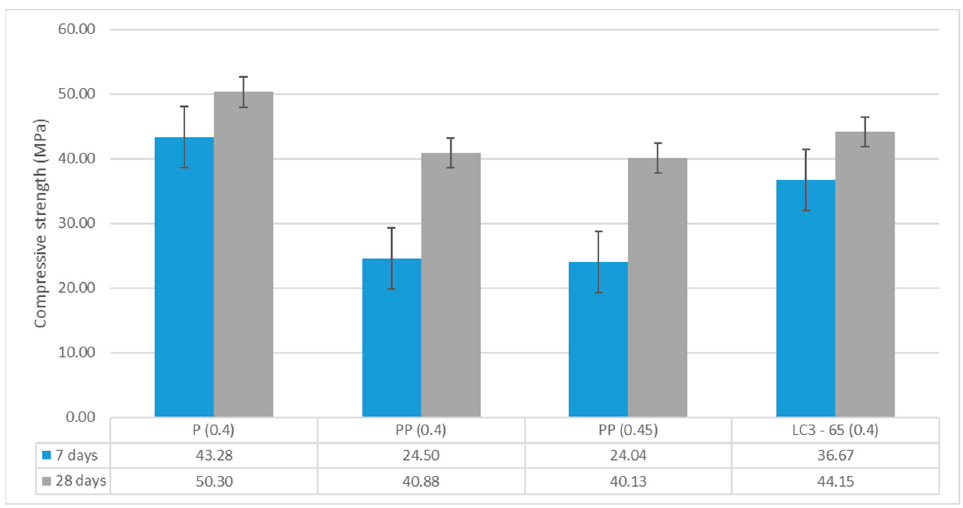
Figure 6. Effect of calcined clay addition on compressive strength.